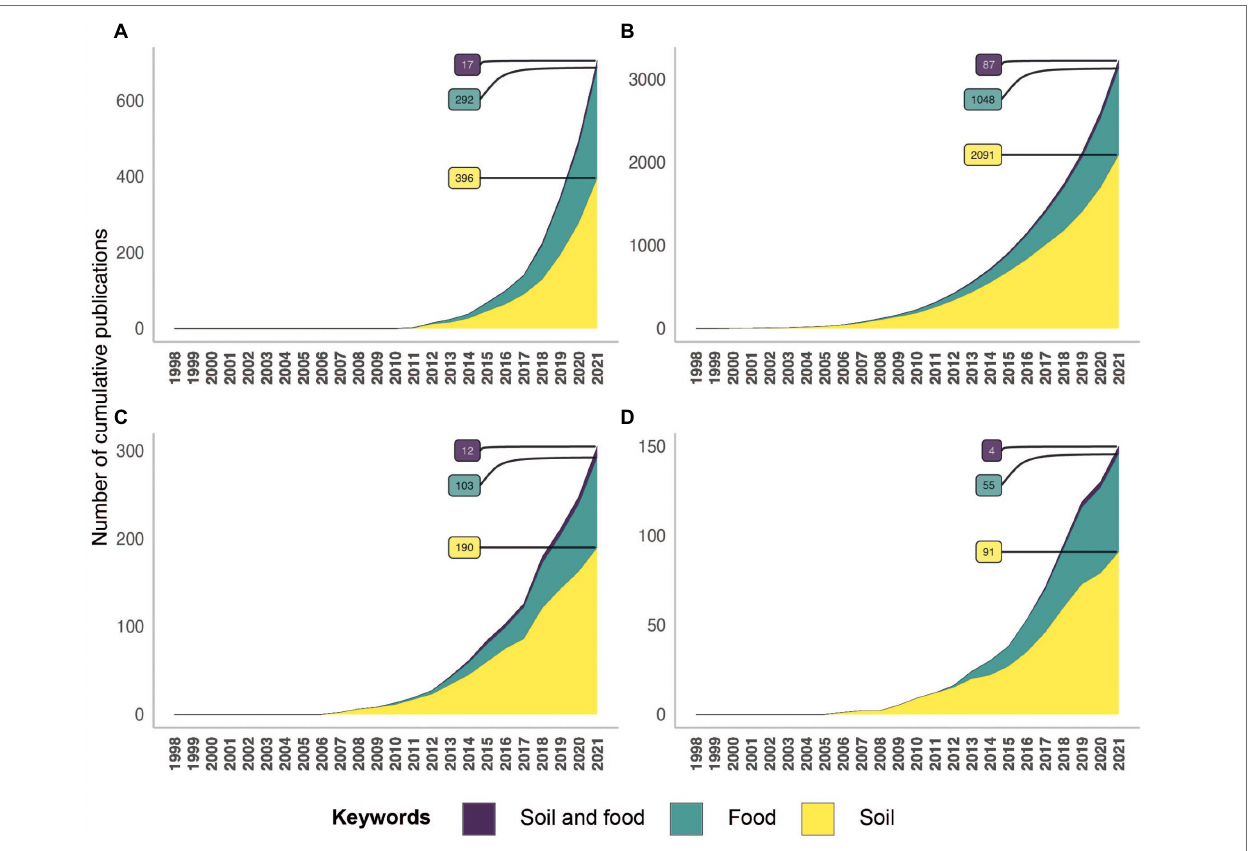
FIGURE 4 | Temporal evolution of the number of references indexed in the Pubmed database concerning meta-omics approaches in relation to soil (yellow), food (green) and soil and food (purple). This analysis relies on keywords present in the title or abstract, related to meta-omics (metabarcoding (A) , metagenomics (B) , metatranscriptomics (C) and meta-proteomics (D) ) across the different research topics (soil; food; soil and food). Concerning the analysis of metagenomics keywords, these can be biased because a lot of publications used “metagenomics” instead of